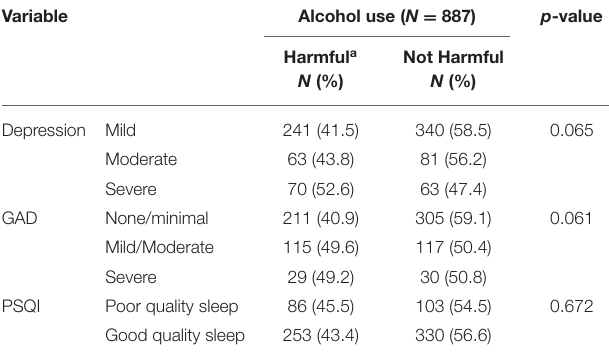
TABLE 4 | Bivariate analysis of mental disorder and harmful alcohol use.